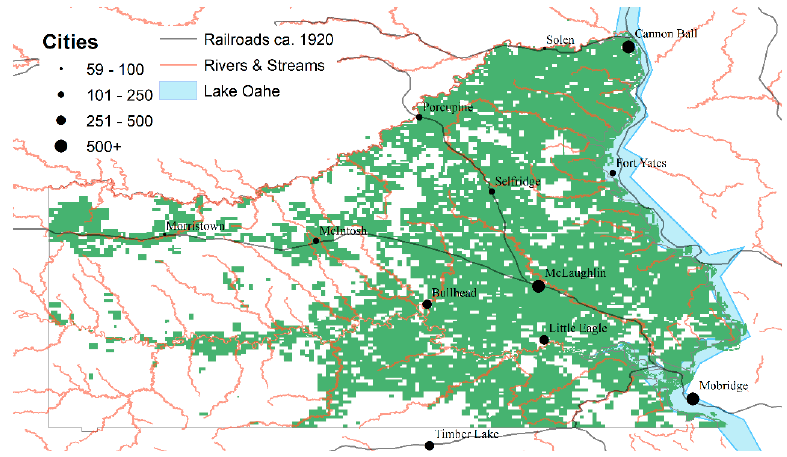
Figure 13. The overall allotment pattern at the Standing Rock reservation.